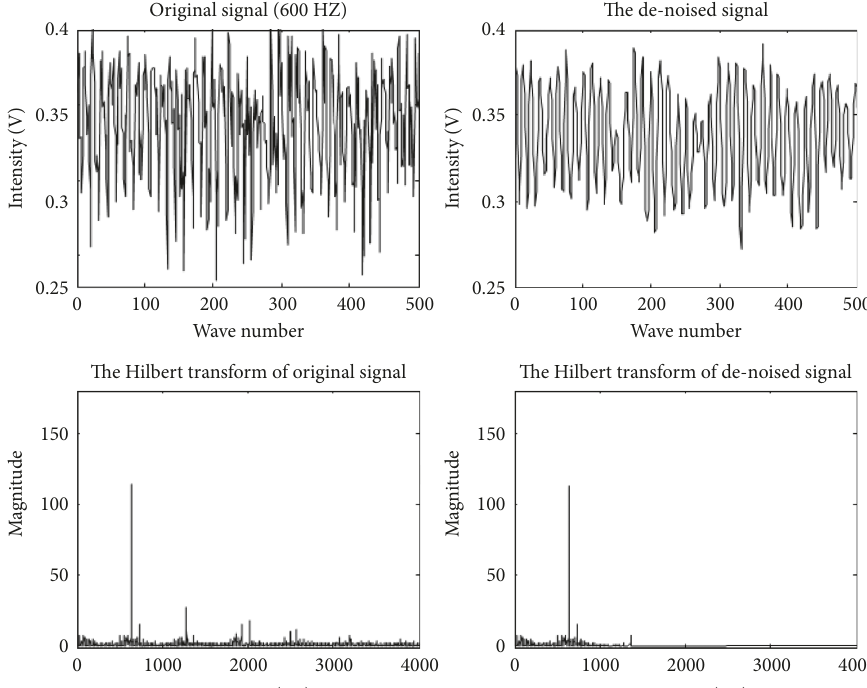
Figure 8: Comparison diagram of original signal and signal and spectrum after wavelet packet decomposition and noise reduction under 600Hz sine wave excitation.